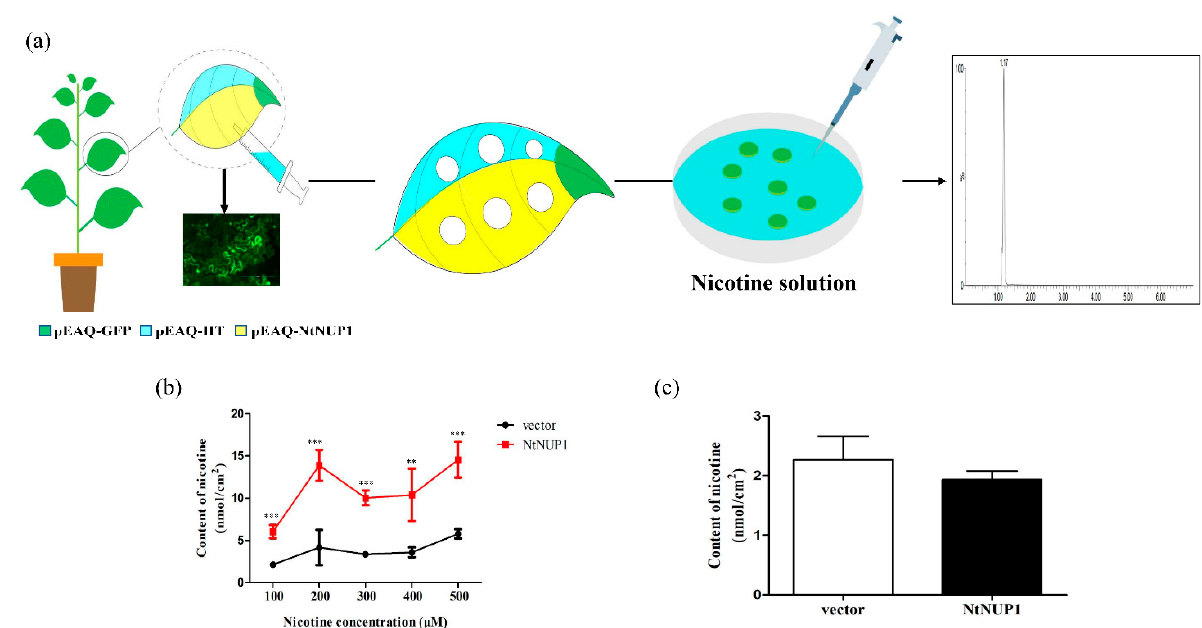
Figure 1. Uptake of nicotine by N. benthamiana foliar discs expressing NtNUP1 . ( a ) Schematic diagram of the nicotine absorption test in N. benthamiana foliar disks. After transient expression of pEAQ- NtNUP1 in N. benthamiana for 2 days, 200 mL of 200 µ M nicotine was evenly applied to the leaf area where pEAQ-HT and pEAQ- NtNUP1 were injected. After 24 h, discs (1.54 cm 2 surface) were obtained from the uniformly illuminated leaf area by the use of a 1.4 cm diameter cork. Upon incubation, the discs were rinsed with a 0.5 mM CaCl 2 solution three times to remove the remaining nicotine. The final extracted solution was analyzed using liquid chromatography–tandem mass spectrometry (LC-MS/MS). ( b ) Uptake of nicotine by foliar discs at different concentration. Line in red is leaves expressing the NtNUP1 gene, and that in black is the empty vector control. The data are presented as the means ± standard deviations ( n = 5) (*** p ≤ 0.001; ** p ≤ 0.01). ( c ) The content of endogenous nicotine in foliar discs; foliar discs were subjected to direct nicotine detection 24 h after pEAQ-HT and pEAQ- NtNUP1 were injected.